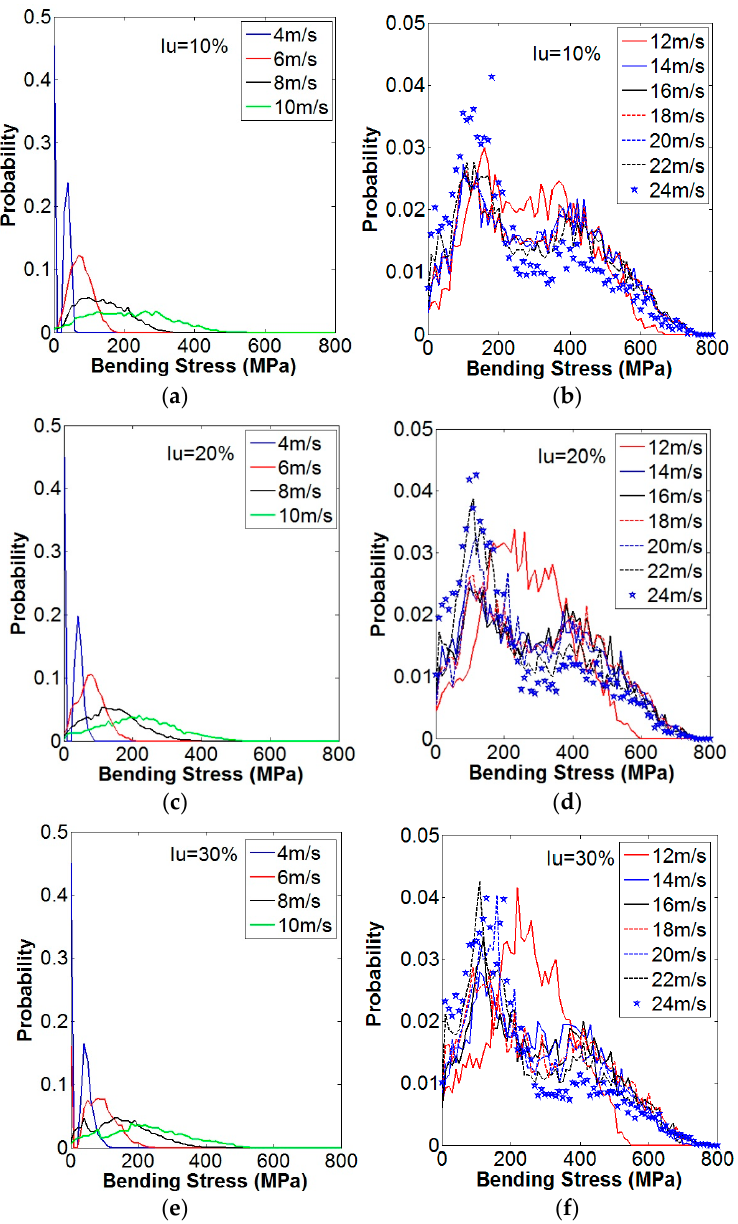
Figure 10. Bending stress of sun gear for wind speeds varying from 4 to 24 m/s with different turbulence intensities: ( a , b ) 10%; ( c , d ) 20%; ( e , f ) 30%.